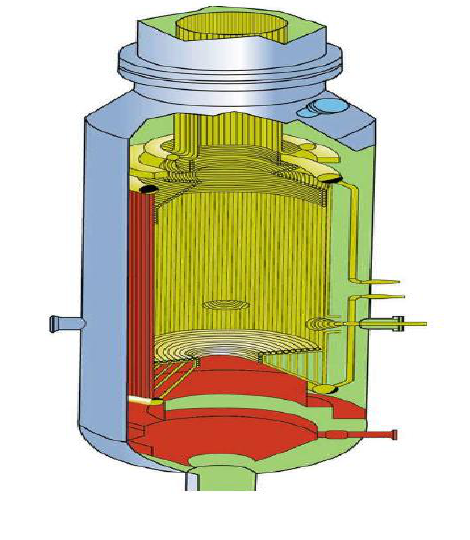
Figure 8. Shell Gasifier